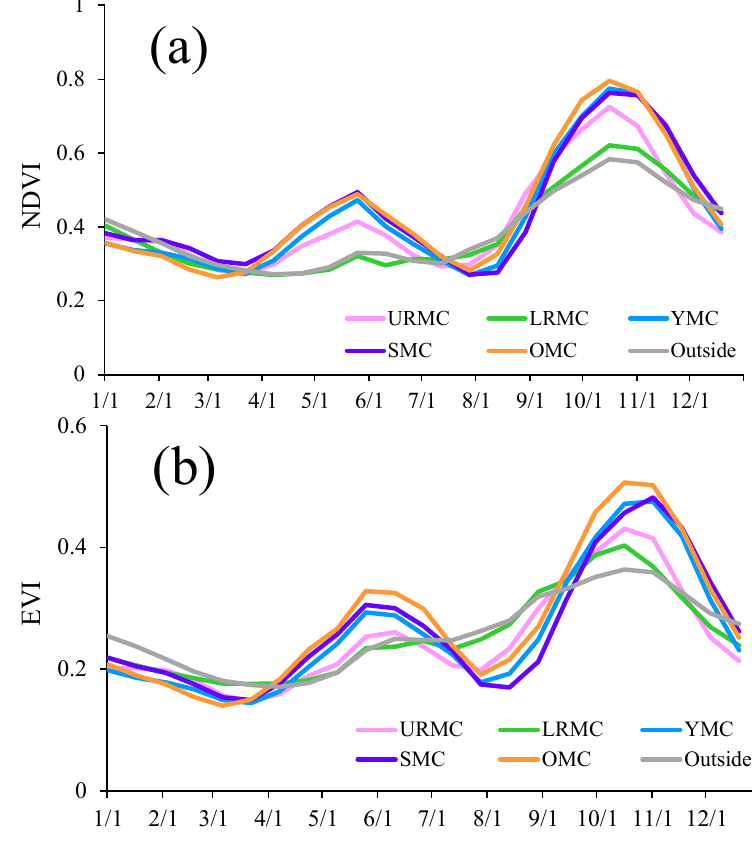
Figure 5. Seasonal changes of ( a ) NDVI and ( b ) EVI in the study area. Figures 6 and 7 depict the seasonal peak NDVI and EVI for summer and monsoon, respectively. The regression line inside the irrigation district was computed using the average of all samples located inside the irrigation district, except for LRMC. The LRMC field samples were omitted from this analysis to better describe the primary field conditions in the district. Information for outside the irrigation district is demonstrated only for the monsoon as no peak was verified for summer cultivation. In both summer and monsoon, the peak VI values inside the district have an increasing trend, implying that they have improved crop growth year-by-year. The slope of the linear regression line in NDVI (Figure 6) was approximately 0.01 in both seasons, indicating that NDVI values increased by approximately 0.2 over the past 20 years from 2001 to 2020. This rate of increase in the NDVI is generally regarded as significant. For example, Ajith et al. [18] reported that the average increment of rice yield for the increment of seasonal peak NDVI from 0.6 to 0.8 was approximately 1500 kg ha −1 or 35%. Belton et al. [21] reported that extremely rapid agricultural mechanization improved crop productivity during their study from 2011 to